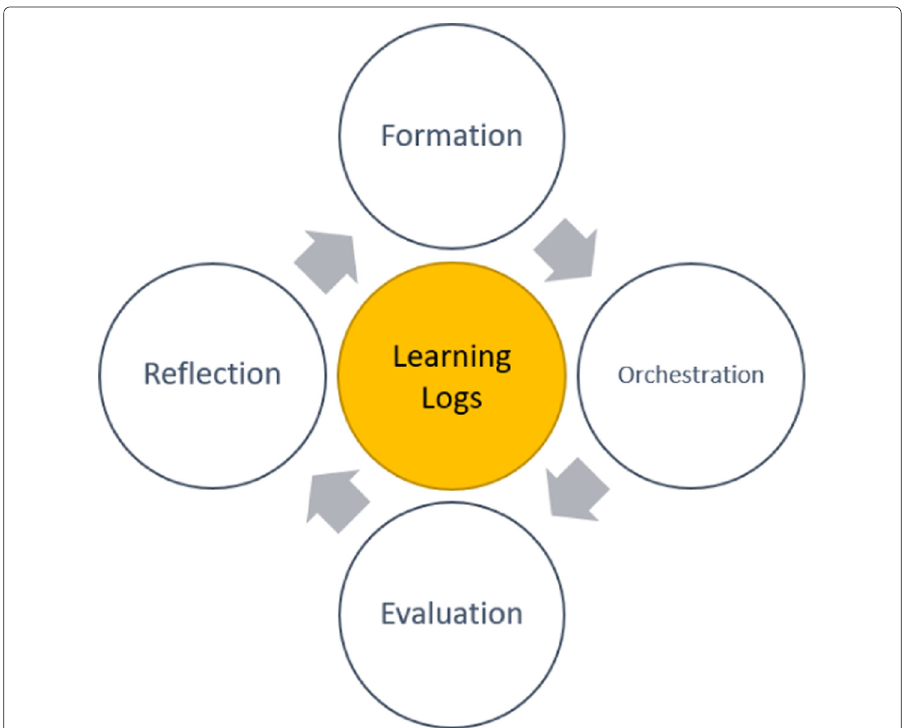
Fig. 1 Group Learning Orchestration Based on Evidence (GLOBE) Framework for collaborative learning support and analysis